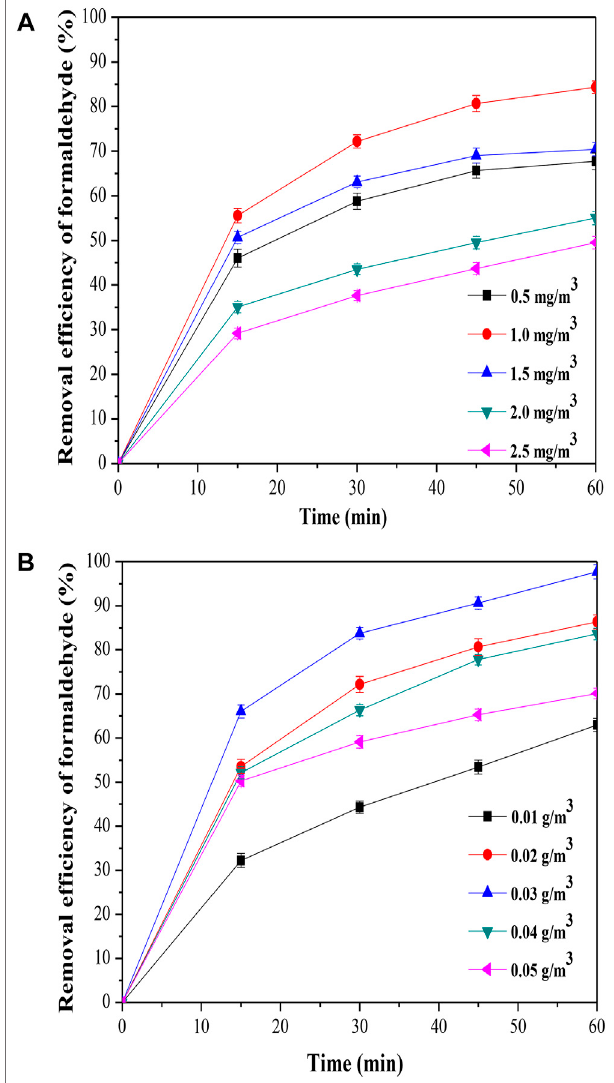
FIGURE 5 | Parameter optimization analysis: (A) Effect of initial formaldehyde concentration on formaldehyde removal; and (B) effect of photocatalyst amount on formaldehyde